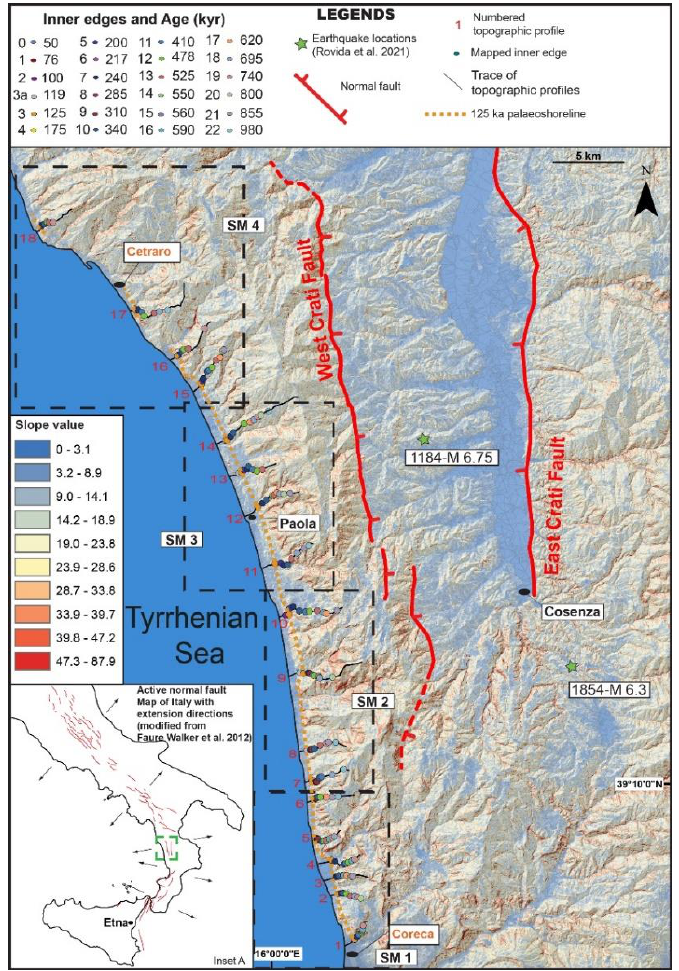
Figure 2. A map with locations of serial topographic profiles along the strike of the West Crati Fault is shown. Coloured dots identify inner edges and associated refined ages along a serial of topographic profiles intercepting raised marine terraces. Dashed squares show where a “zoom–in” has been carried out as Supplementary Material (SM) to better show traces of topographic profiles and locations of inner edges with refined ages on a 10 m high–resolution digital elevation model. Dashed orange trace shows the mapped palaeoshoreline identifying the Last Interglacial Maximum (LIG), MIS 5e